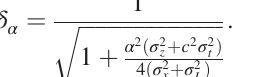
9. Case F. Left graph: Δ E Δ E =E 0 . 1 . Right graph: ϵ L L ¼